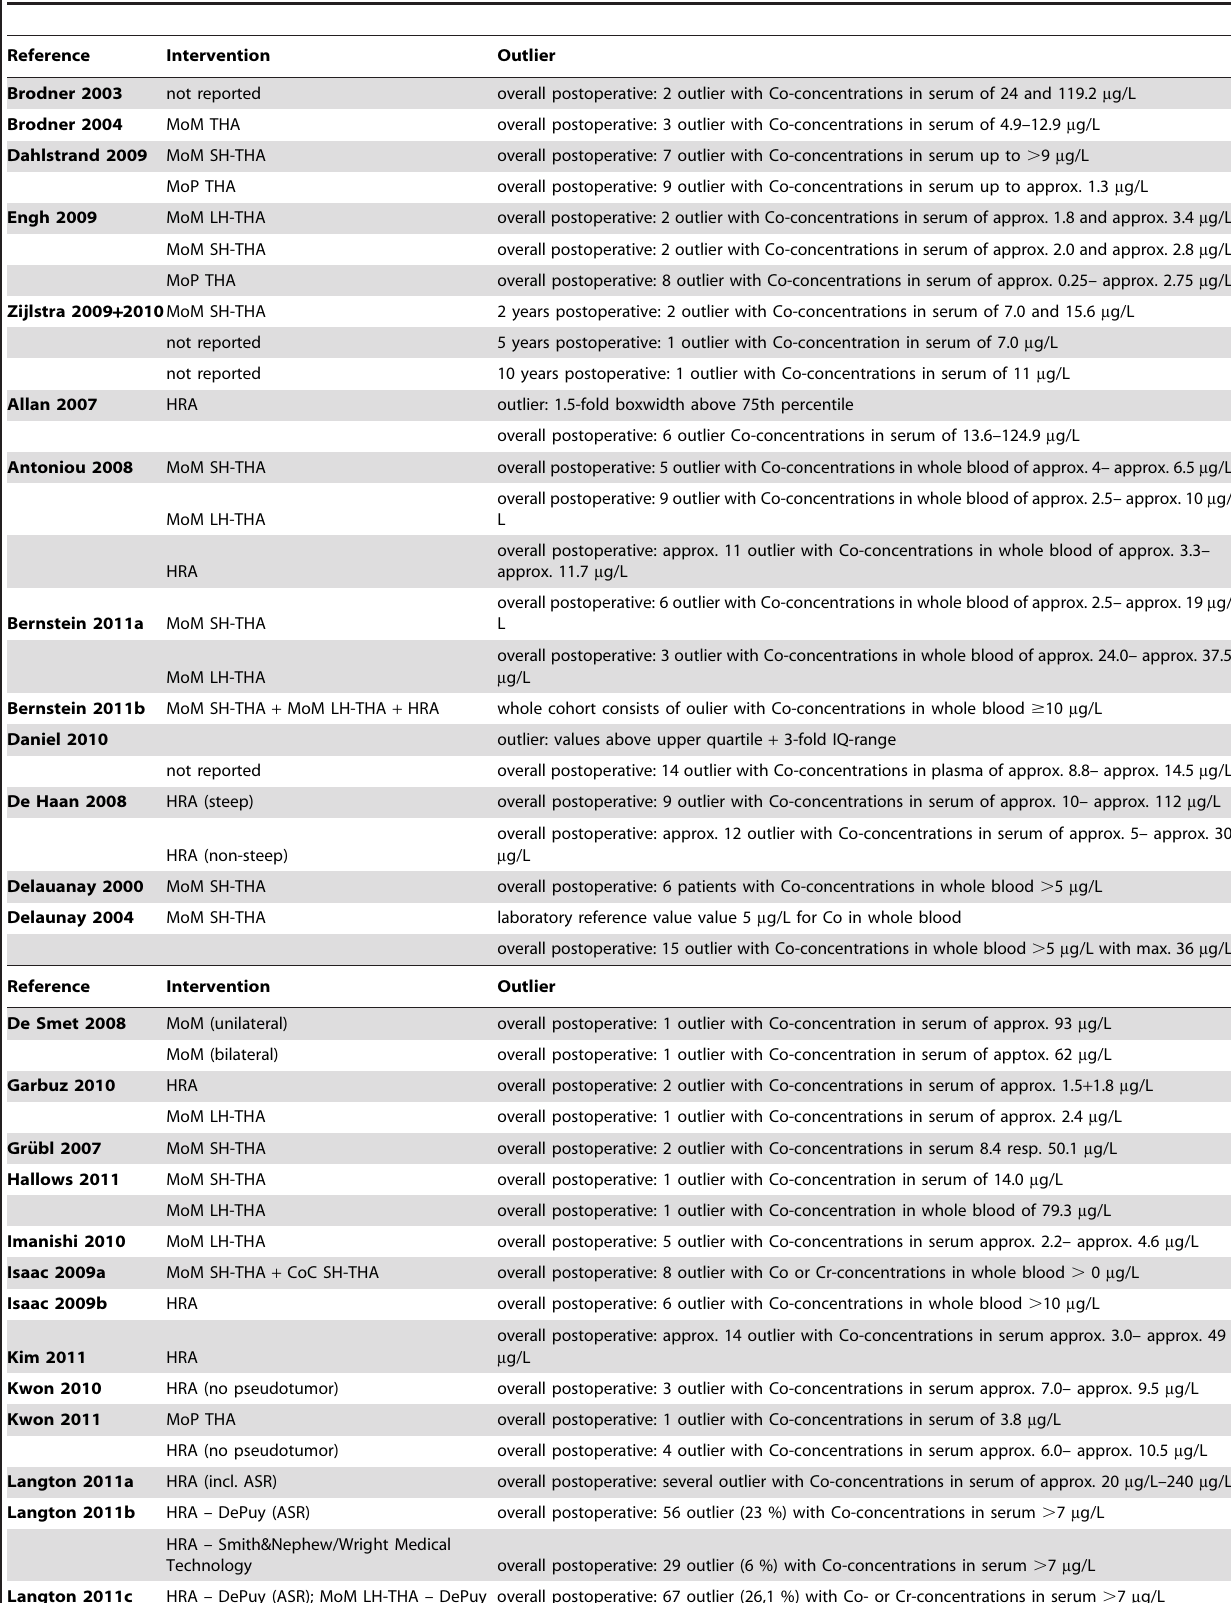
Table 11. Maximal postoperative Co-concentrations after THA in RCTs and epidemiological studies.